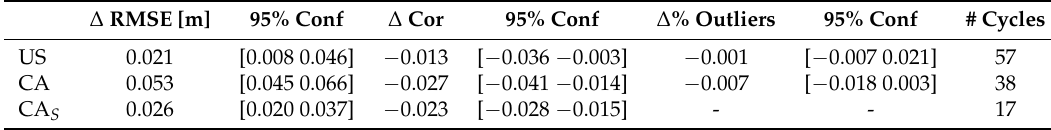
Table 2. The median and 95% confidence interval of the difference (ocean—OCOG) in the validation measures; RMSE, Pearson correlation and the percentage of outliers, between the two retrackers ocean and OCOG. The subscript s indicates the case based on summer data only. ∆ RMSE [m] 95% Conf ∆